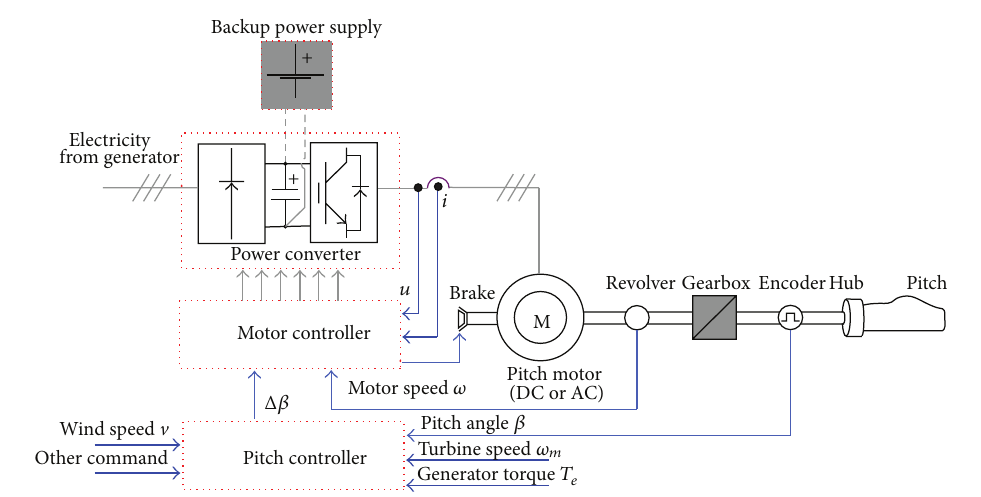
Figure 4: Configuration of pitch regulation control system in the WECS.